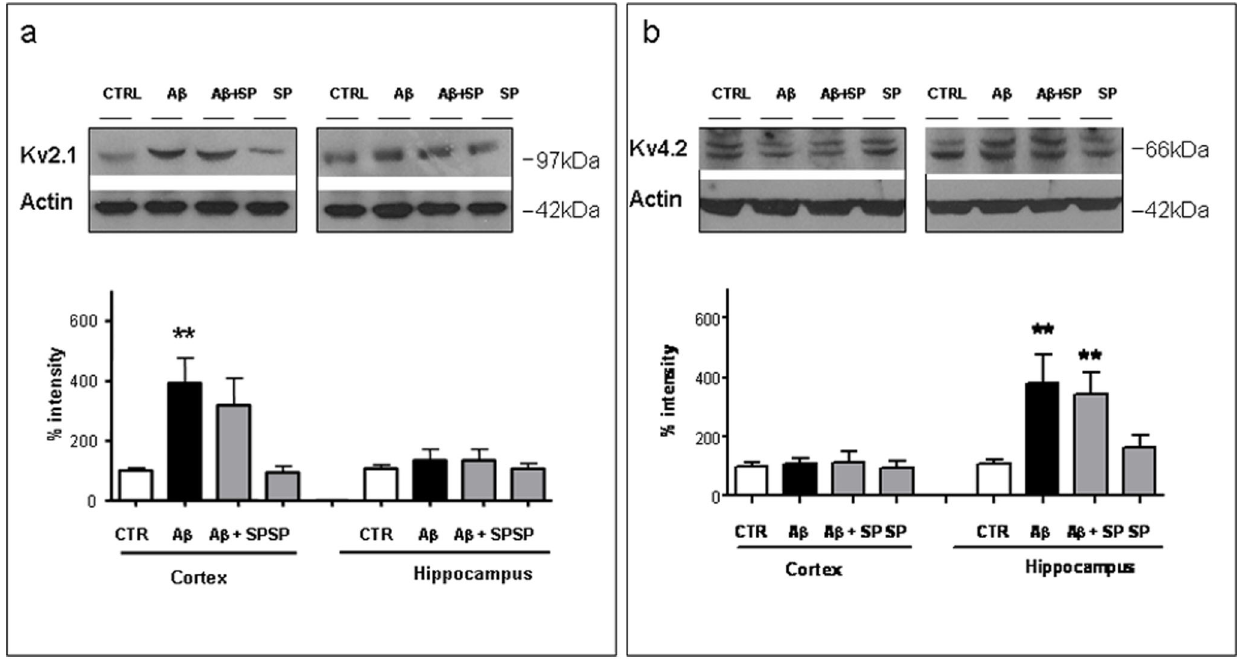
Figure 2. Western blot analysis of Kv 2.1 and Kv4.2 subunit expression in cerebral cortex and hippocampus. Representative immunoblot of cerebral cortex and hippocampus enriched membrane proteins (50 m g/lane) from (Ctr), A b 25–35 , A b 25–35 + SP and SP treated rats. Protein markers are shown at right (in kDa). The immunoreactive signals for a ) Kv2.1 and b ) Kv4.2 were quantified and normalized against b -actin and expressed as a percentage of control (CTR). Data represent mean ( 6 SEM) from 3 independent experiments. Statistically significant differences were calculated by one-way analysis of variance (ANOVA) for repeated measures followed by Tukey’s test for multiple comparisons (**p , 0.01 versus Ctr